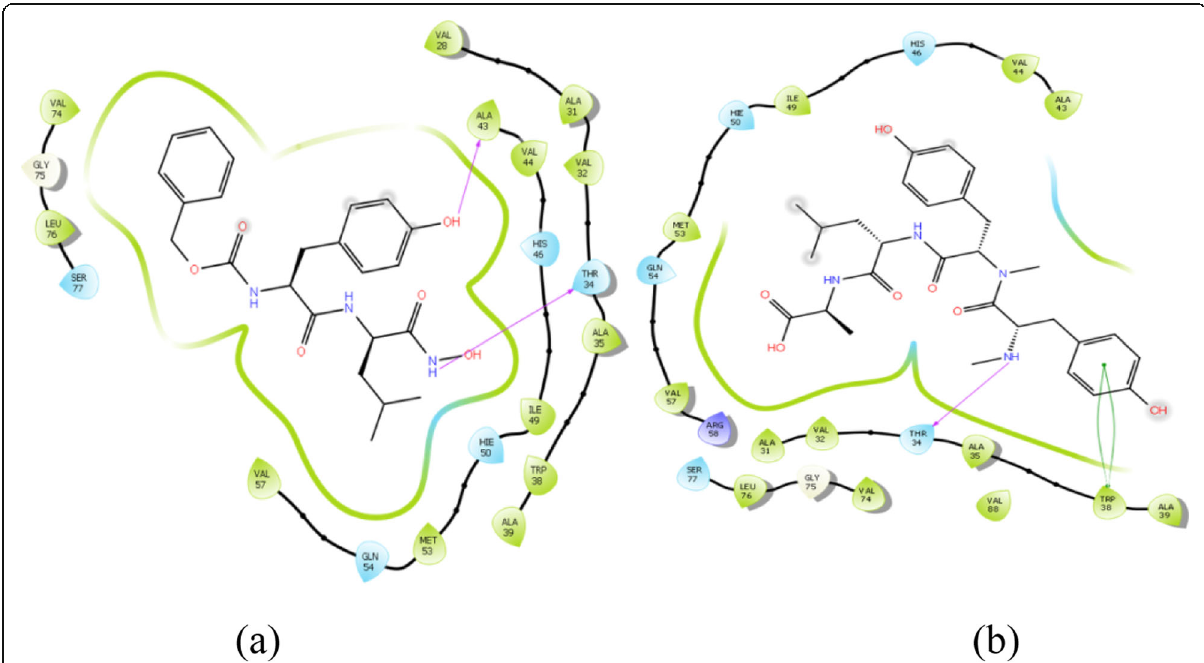
Fig. 5 a Target-ligand interaction diagram of GP63-46173719. b Target-ligand interaction diagram of GP63-UNPD86509